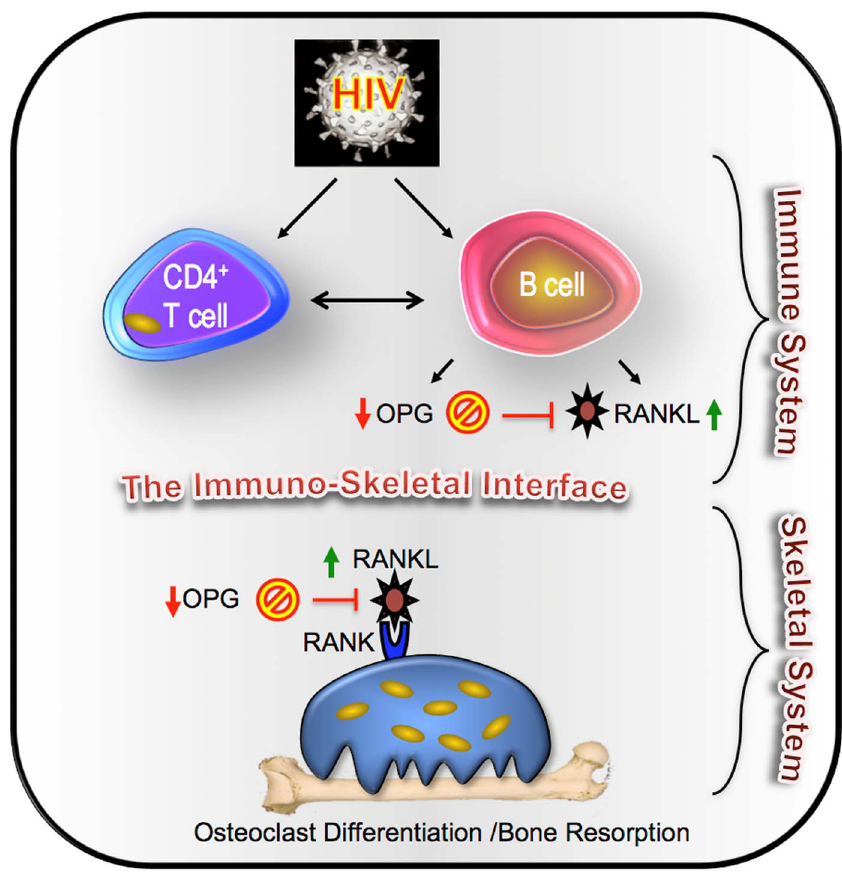
Figure 4. Immunocentric model of HIV induced bone loss. We propose a model for HIV- induced bone loss whereby HIV infection, either through direct effects on B cells, or though disruption of T cell costimulation of the humoral system, leads to a decline in the frequency of B cells secreting OPG, coupled with an increase in the frequency of B cells secreting RANKL. This disruption of the immuno-skeletal interface results in an increase in the RANKL/OPG ratio that is permissive for osteoclast formation and enhanced bone resorption, which ultimately contributes to bone loss and the elevated bone fracture risk characteristic of HIV-infected individuals.